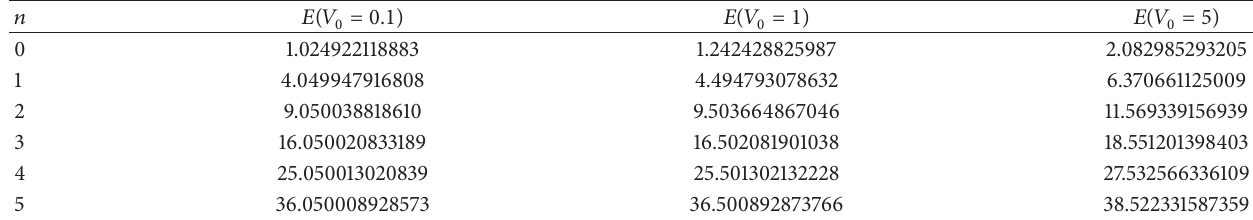
Table 7: Approximate energy levels for a confined sine squared potential 𝐻 = −Δ + 𝑉 0 sin 2 (𝑥) in dimension 𝑑 = 1 . For the state 𝑛 , 𝐸 denotes the upper bound for the energies obtained using the present variational analysis with basis size 𝑁 = 25 and fixed 𝐿 = 𝜋/2 . The table shows the energies of the first 6 states 𝑛 = 0, 1, .. ., 5 .